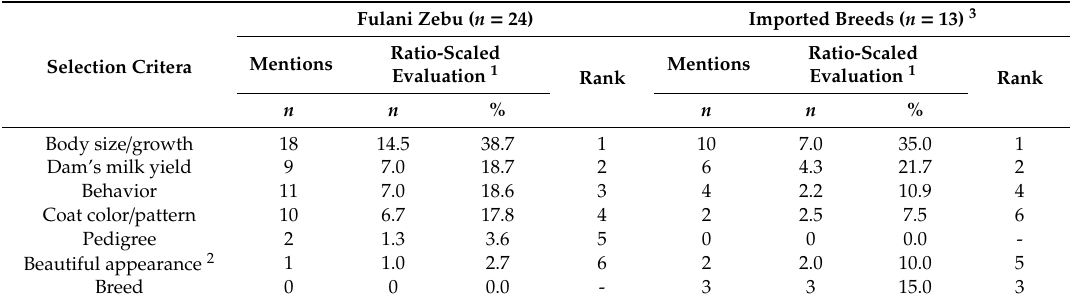
Table 4. Criteria used to select bulls for replacement (cattle breeders n =